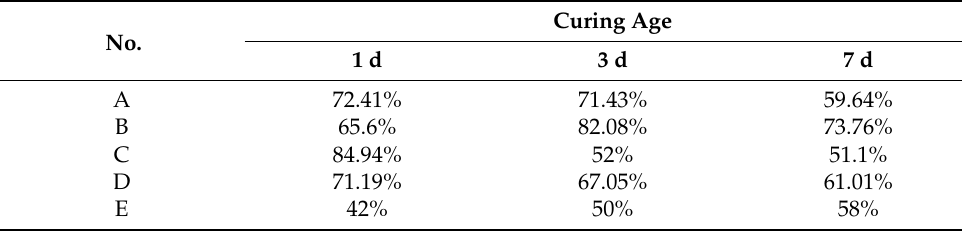
Table 3. Percentage of maximum rebound stress to maximum compressive